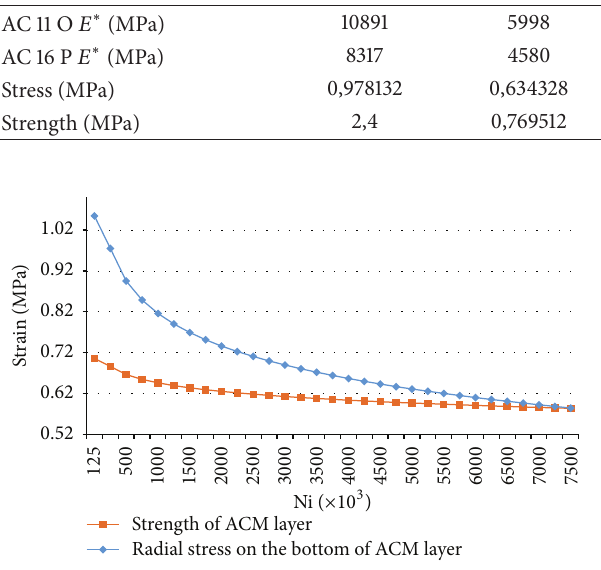
Figure 5: Relationship between stress in ACM depending on repeated loading and decrease of ACM strength resiliency depend- ing on the fatigue trend function.